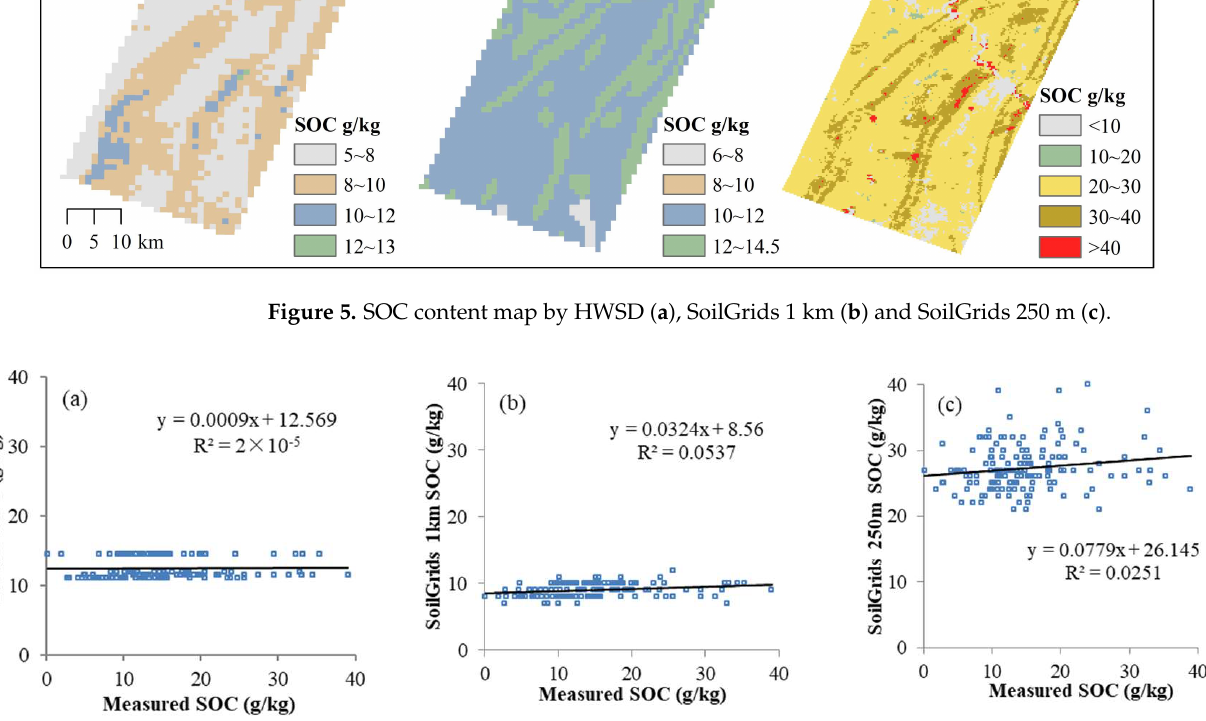
Figure 6. Validation of the measured SOC with ( a ) HWSD, ( b ) SG1k m and ( c ) SG250m.